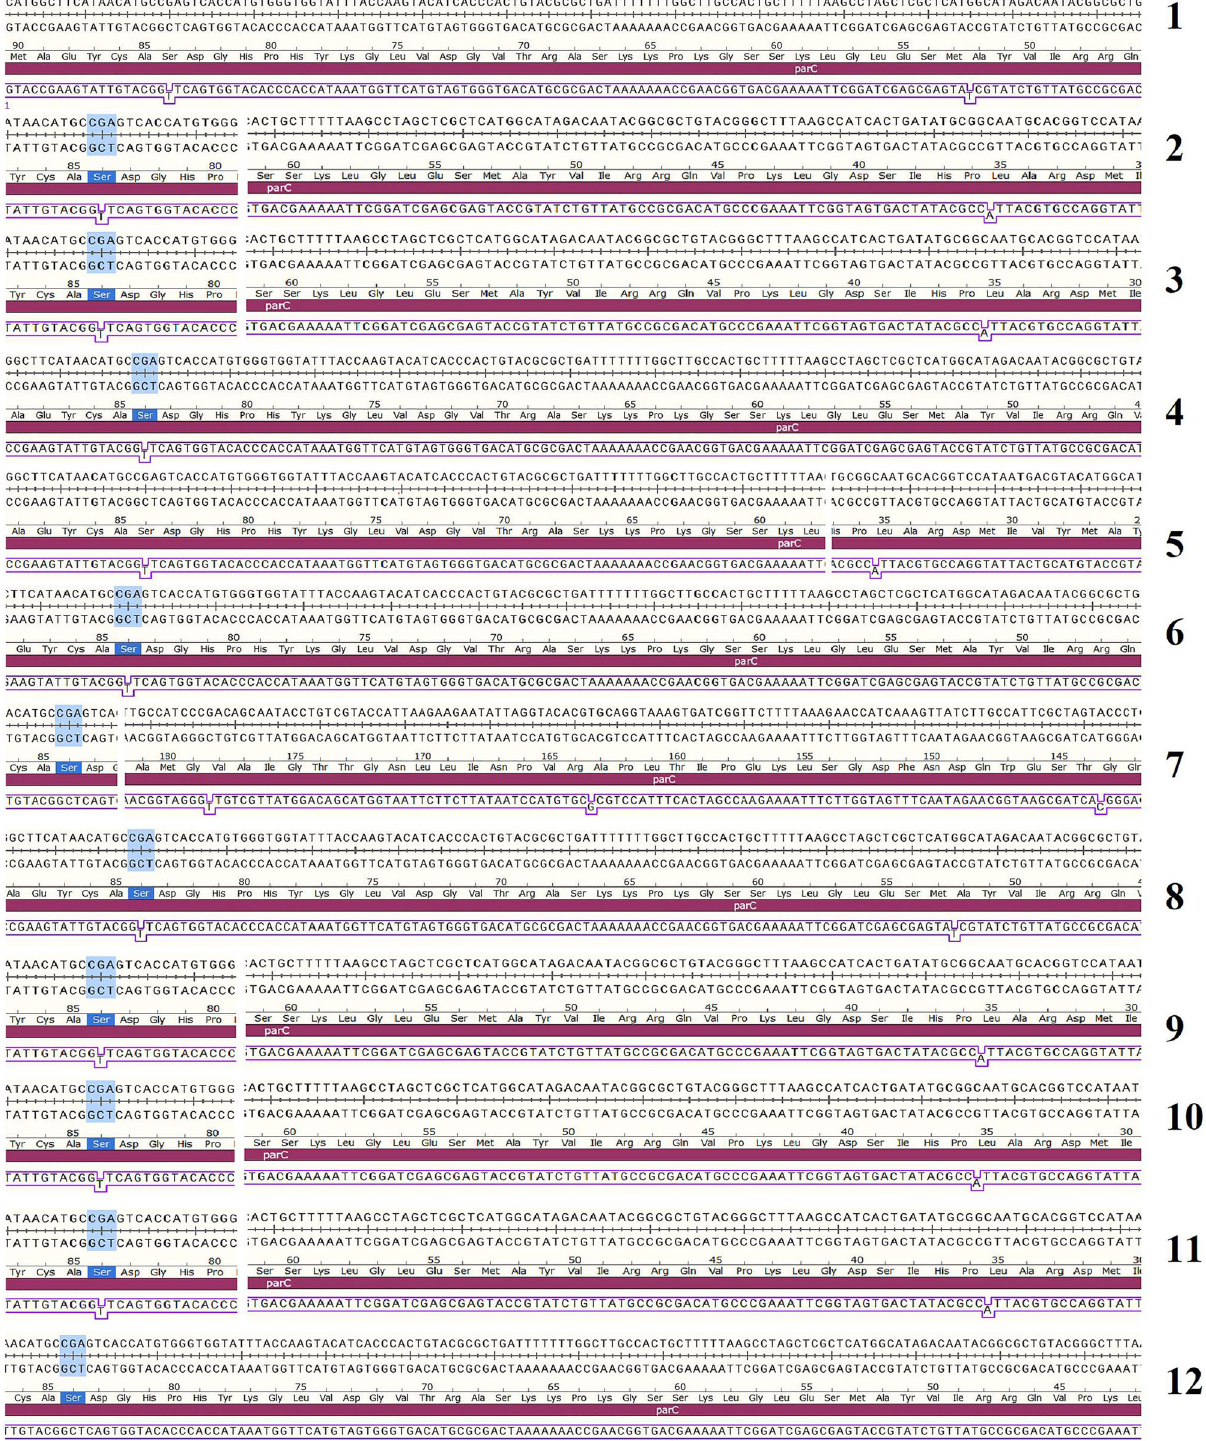
Figure 4. Pairwise alignment of nucleotide sequences (CDS region) of ParC genes of 12 tested A.baumannii isolates versus the wild type gene of A.baumannii ATCC 19,606 retrieved from the GeneBank database using SnapGene Viewer